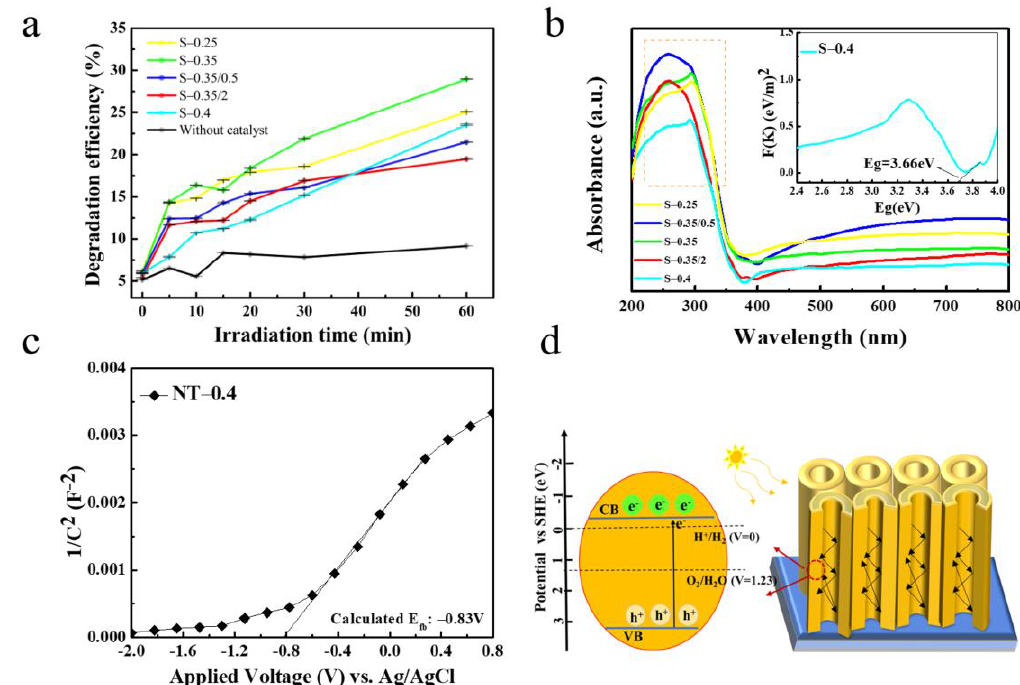
Figure 7. ( a ) Photocatalytic degradation of Rhodamine B (Rh B) in as-prepared Nb 2 O 5 NA samples in different conditions under UV light irradiation. ( b ) Diffuse reflectance UV-vis spectra of as-prepared anodic oxides. ( c ) Mott Schottky plots of sample S-0.4 synthesized in 0.4 M NH4F solution containing